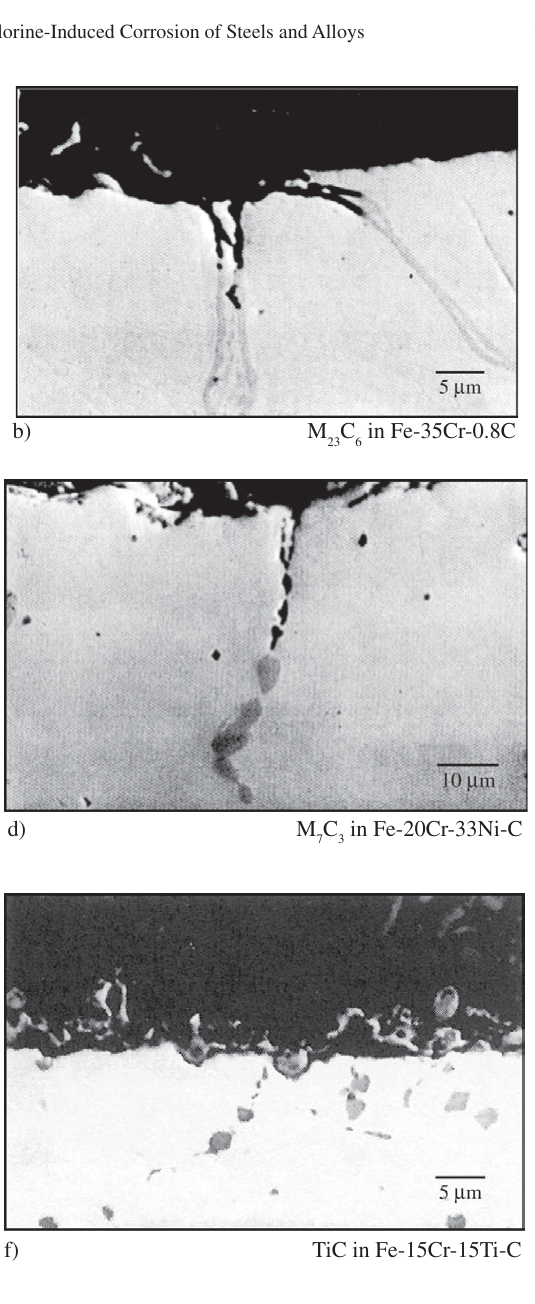
Figure 4. Metallographic cross sections of model alloys with well- defined carbide precipitates after 168 corrosion in N 600 °C. a-d) the chromium carbides M selectively; e-g) Mo-rich carbide M more corrosion resistant than the